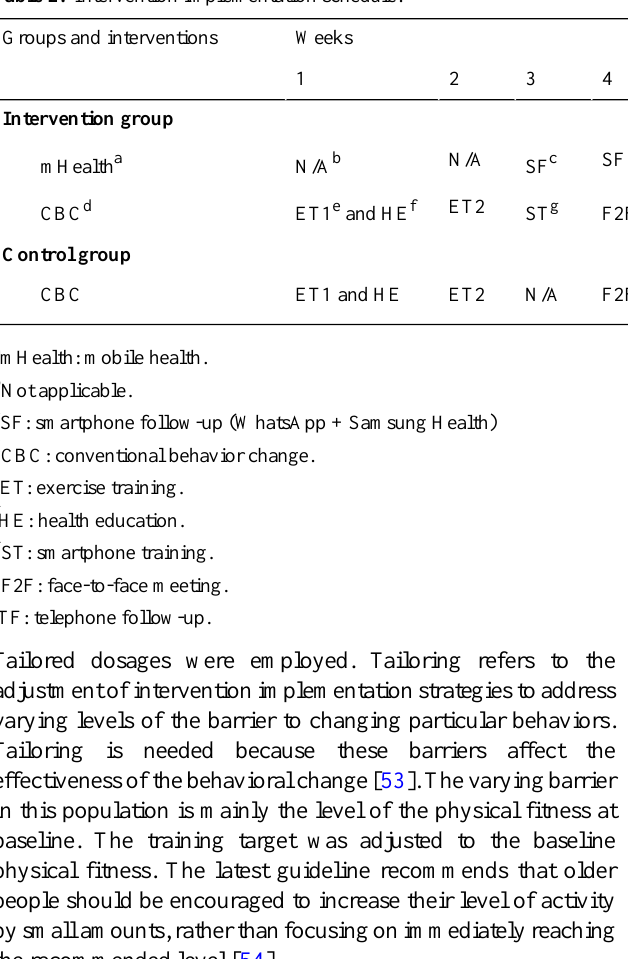
Table 2. Intervention implementation schedule.